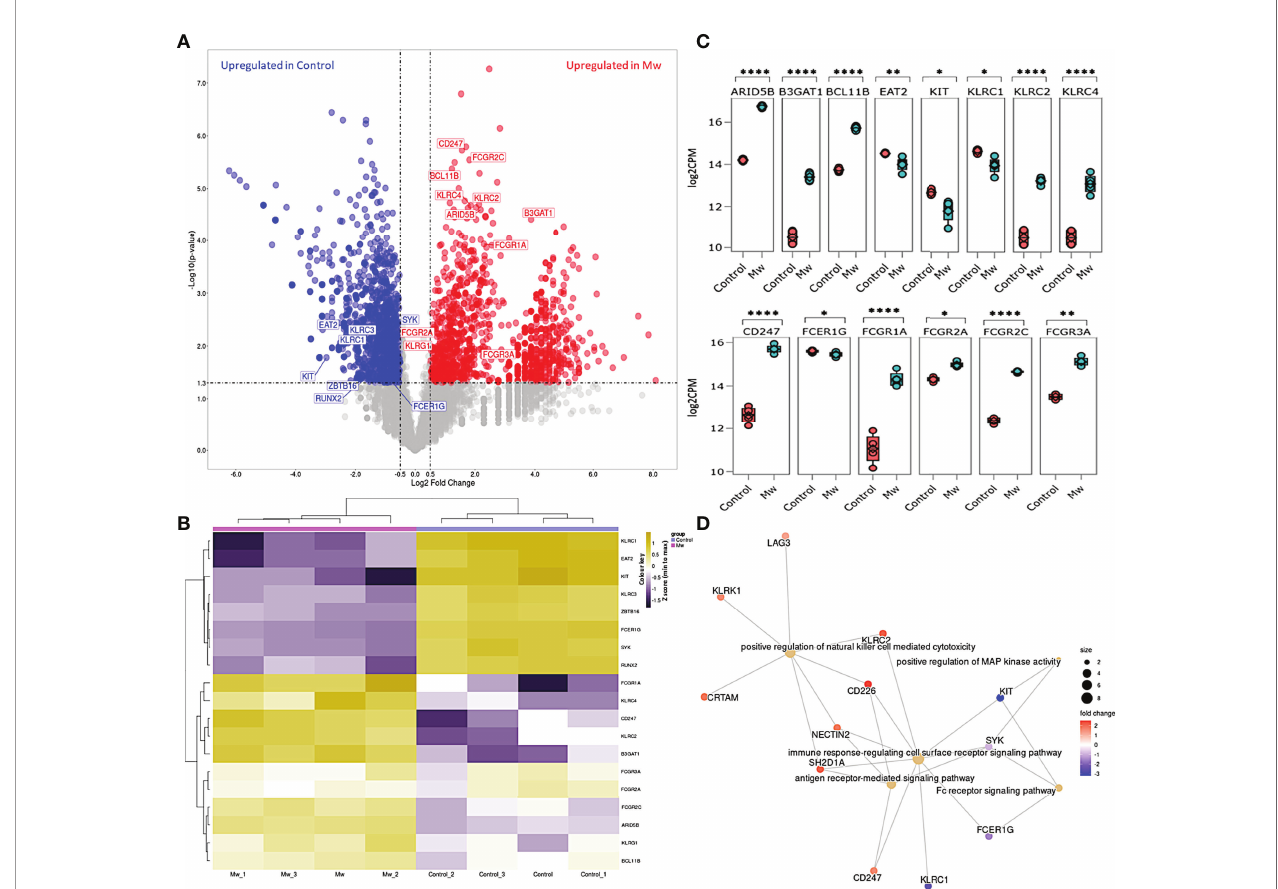
FIGURE 7 | Differential gene expression and network analysis in Mw and Control group: (A) Volcano plot showing genes differentially expressed in Mw as compared to control group. Genes with a p-value <0.05 and log2 fold change ≥ 0.5 ≤ -0.5 were considered signi fi cant. Selected genes are highlighted (Red: upregulated in Mw group, Blue: upregulated in control group). (B) Heatmap of RNA-seq expression data showing selected DEGs related to this study. Hierarchical cluster analysis was performed between all samples of Mw and Control groups. Gene expression is shown in normalized log2 counts per million. (C) Boxplots showing expression levels of 19 selected genes in Mw (green) as compared to control group (orange). Relative gene expression is shown in normalized log2 counts per million (log2CPM) for I) ANK pathway in the top panel, II) ADCC pathway in the middle panel. (*p-value < 0.05, **p-value < 0.01, ****p-value<0.0001). (D) GO network analysis of the top 5 enriched GO terms in the DEGs for adaptive NK cell and antibody-dependent cellular cytotoxicity (Fisher ’ s exact test using enrichGO function in R package clusterPro fi ler, multiple test correction by the Benjamini – Hochberg method, adj. p-value